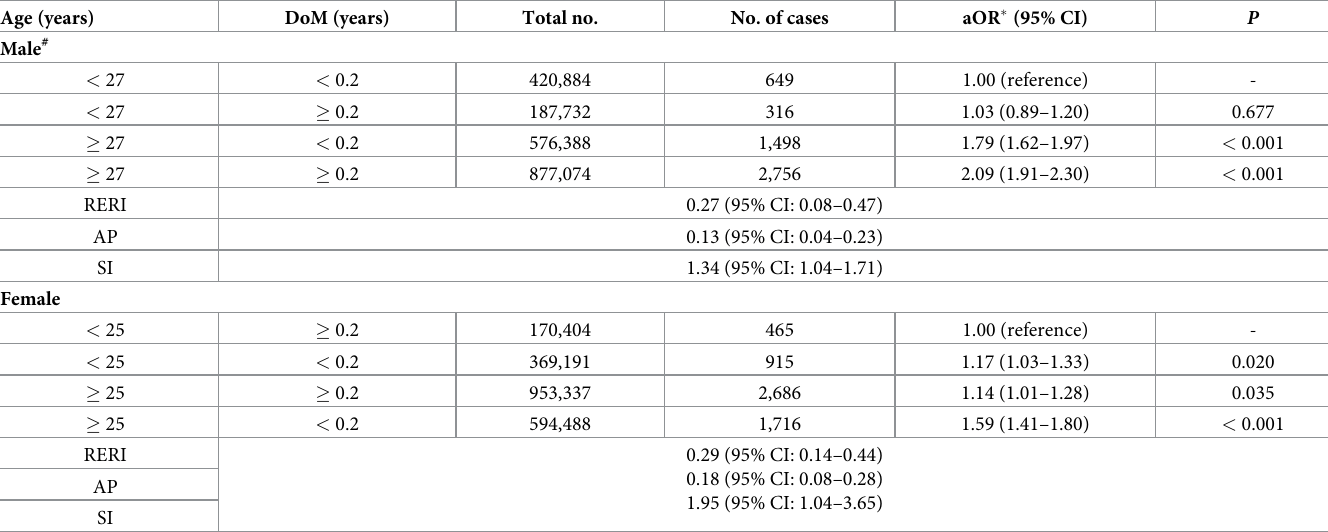
Table 3. The interactive effects between age and DoM on PSS among married individuals aged 21–49